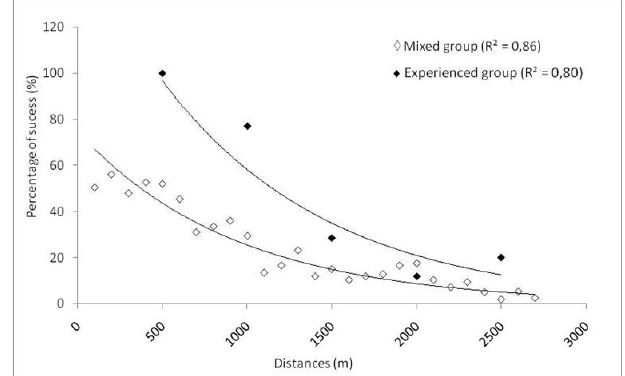
Fig 2. Percentages of success of Melipona mandacaia bees returning to their nests in relation to the distance from where they were released for the “Experienced group” and “Mixed group”.